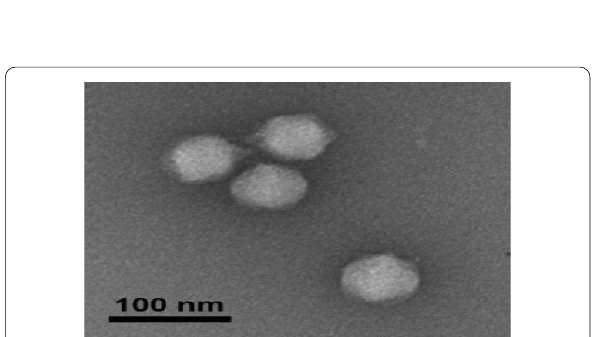
Fig. 1 Plaque assay for ɸ ParuNE1 Phage: A, Spot test for the detection of ɸ ParuNE1 phage; and B, a higher dilution (10 − 6 ) of phage titer showing clear plaques with an average diameter of 0.8 mm